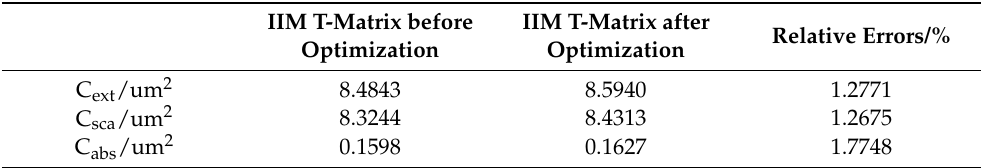
Table 5. The integral scattering properties of the hexagonal prism particles calculated by IIM T-matrix models before and after optimization. Table 4. The integral scattering properties of the twelve prism particles calculated by IIM T-matrix IIM T-Matrix and DDA methods.